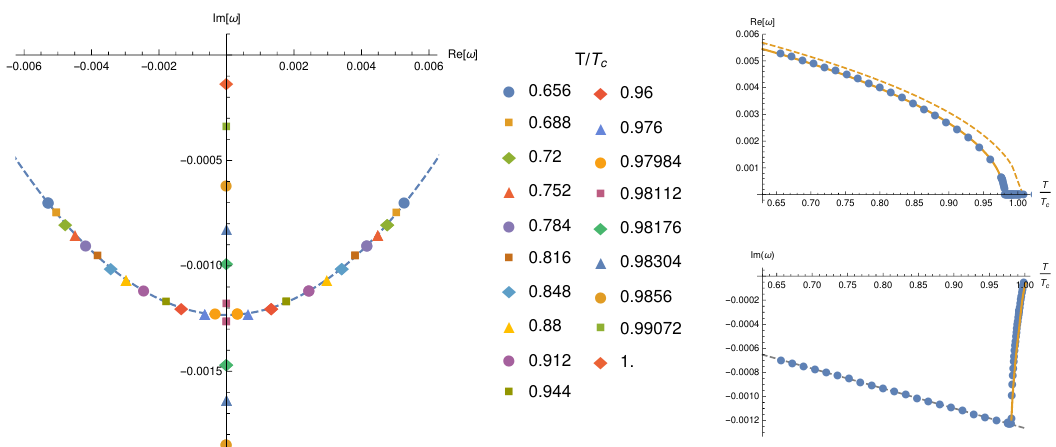
Figure 7 . QNMs in the states with (cid:12)xed explicit scale (cid:21) = 0 : 5 and increasing temperature. As the temperature approaches the critical point T c the phonon QNMs become purely di(cid:11)usive. Yellow curves show the (cid:12)t using the order parameter scale (3.3), yellow dashed line displays the appropriately normalized order parameter h J 2 i itself. Left panel: trajectories of QNMs in the complex plane, Right panel: dependence of the real and imaginary parts on T